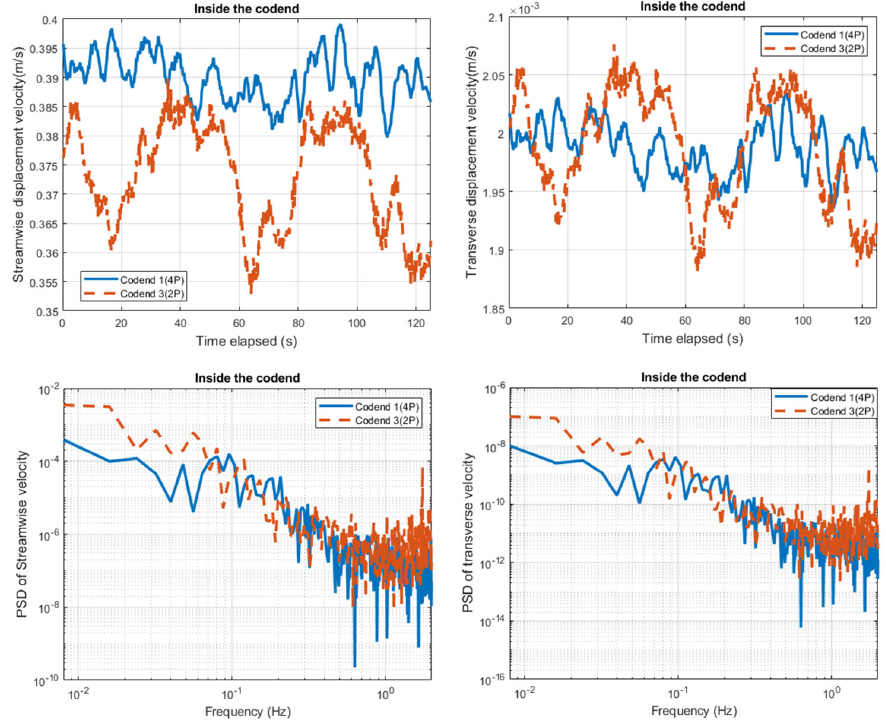
Figure 13. Time evolution of the streamwise velocity ( right ) and transverse velocity ( left ) linked to the normalized frequency spectrum (bottom in a log-log scale) inside the different codends .